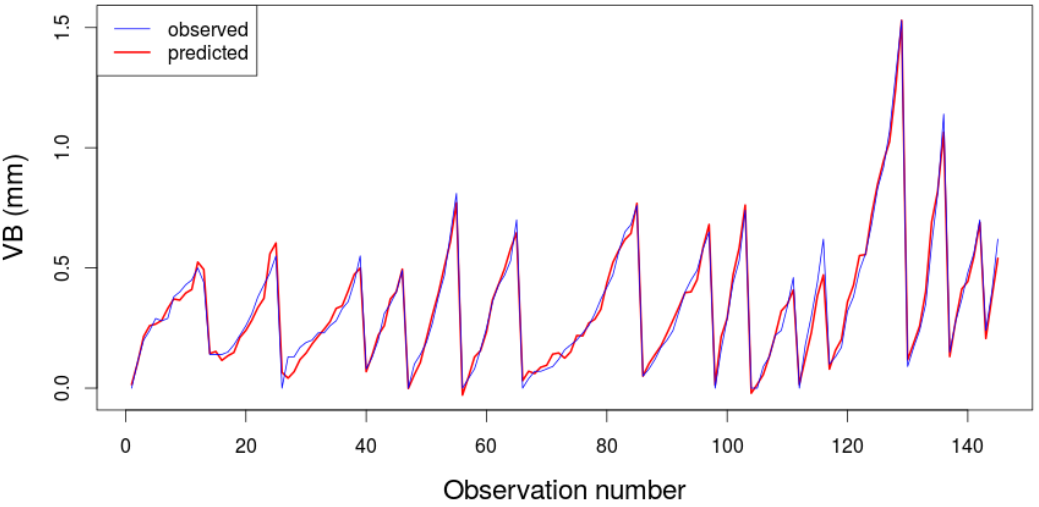
Figure 9. Comparison between the flank wear (VB) in mmmeasured experimentally and flank wear predicted by the ABC–MARS-based model in the milling process using the optimal hyperparameters ` ˘ 94.0 2 R . R 2 “ 0.94